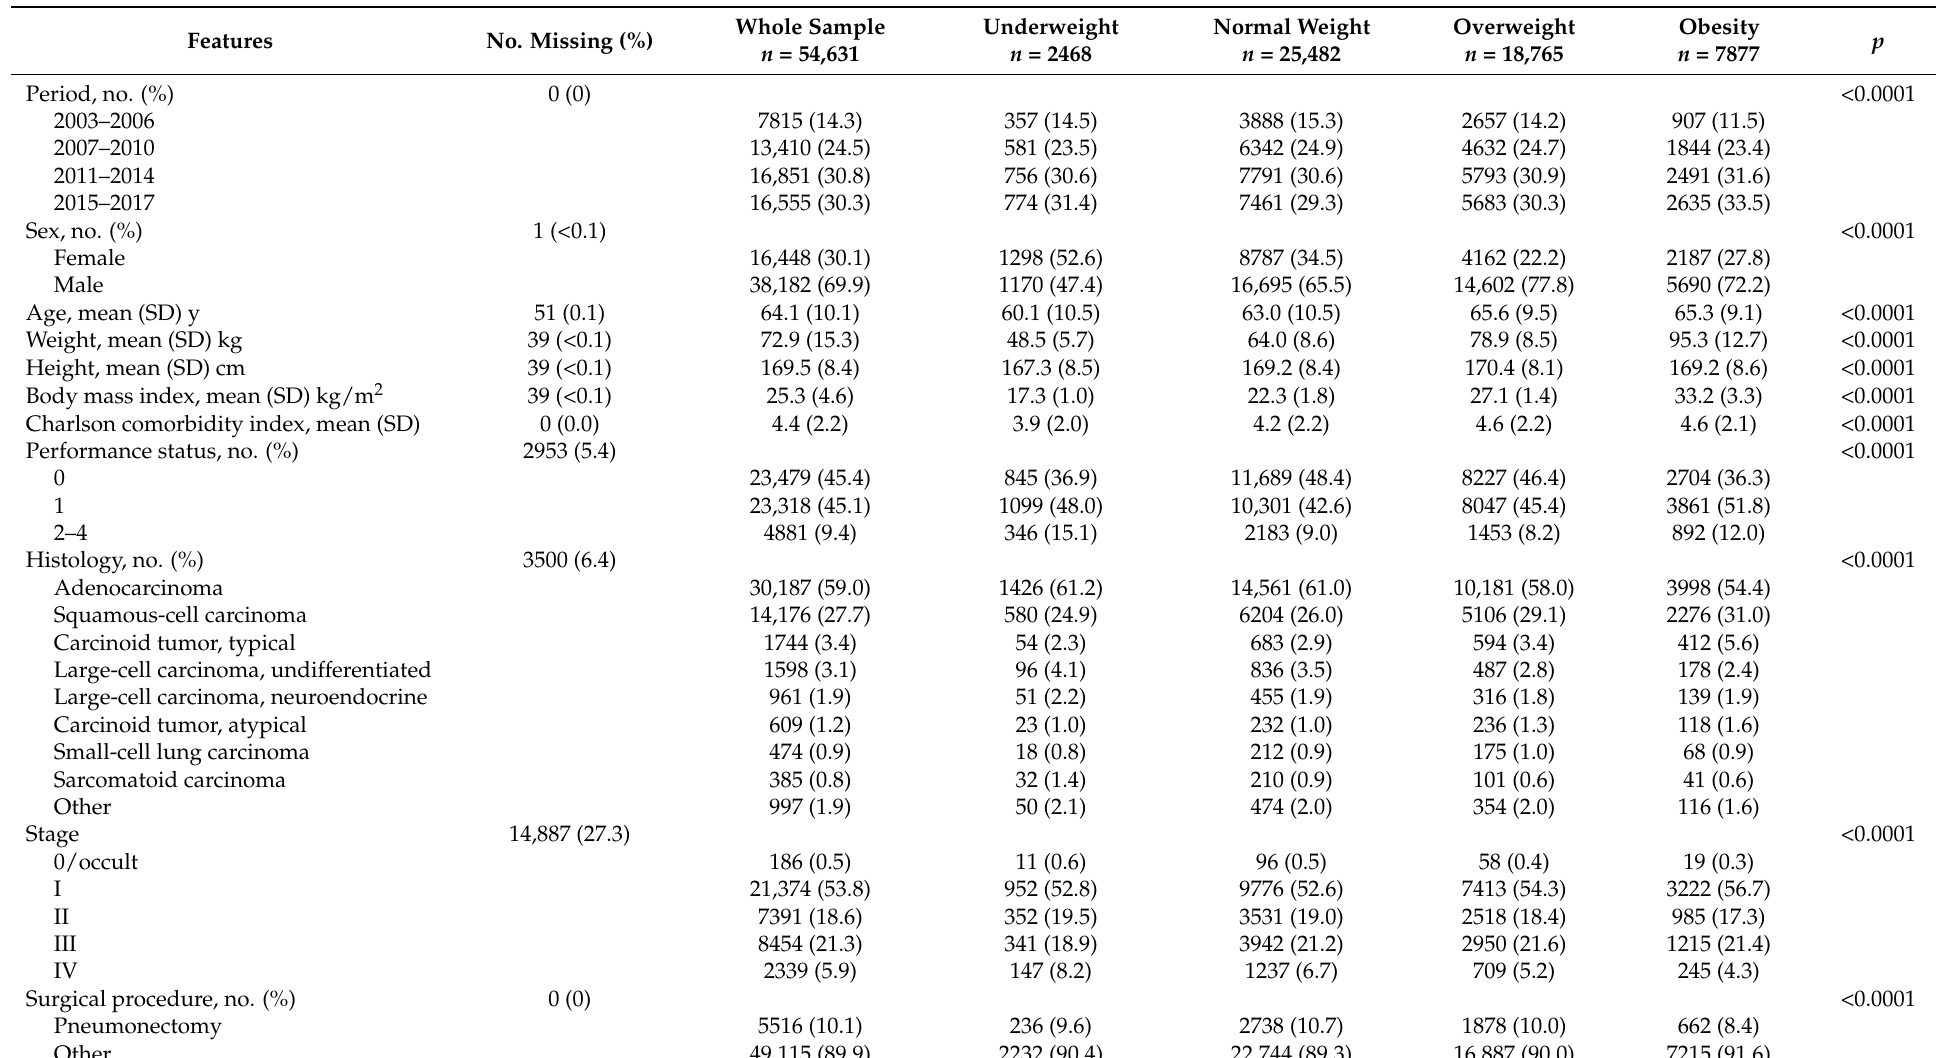
Table 1. Characteristics of patients at the time of